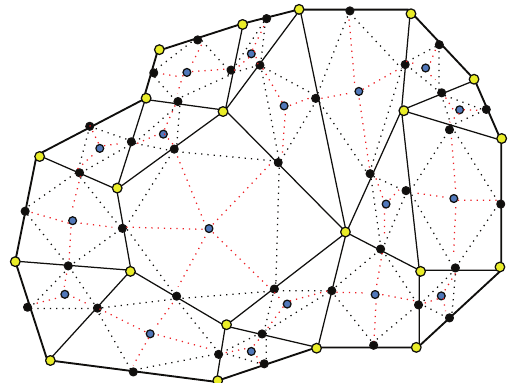
Figure 5: A dual cell (blue discontinuous line) with its four pseudoedges “centered” on red